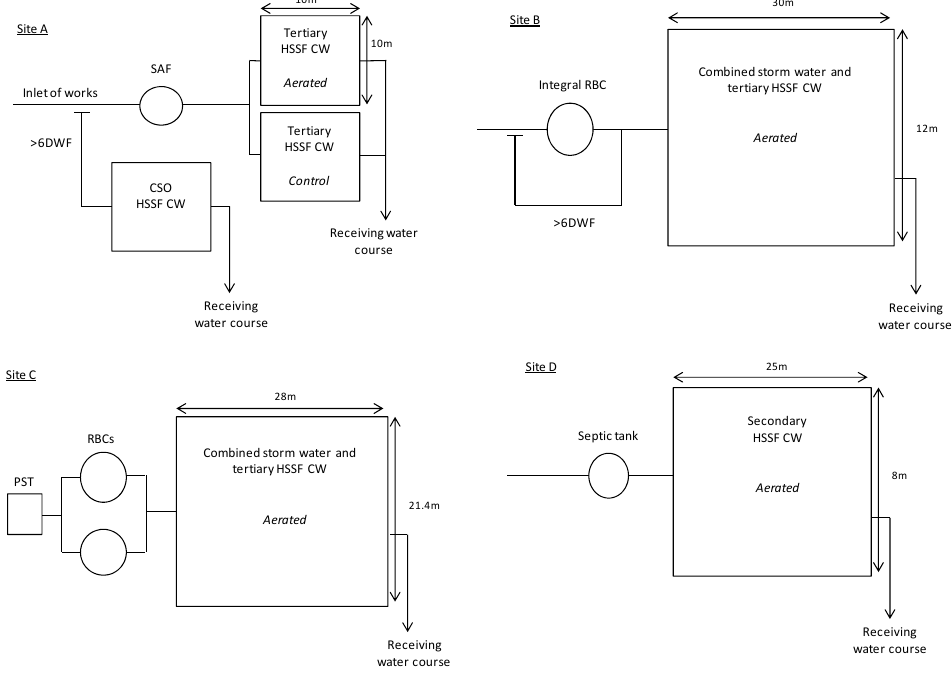
Figure 1. Site process flowsheets of aerated HSSF CW sites.